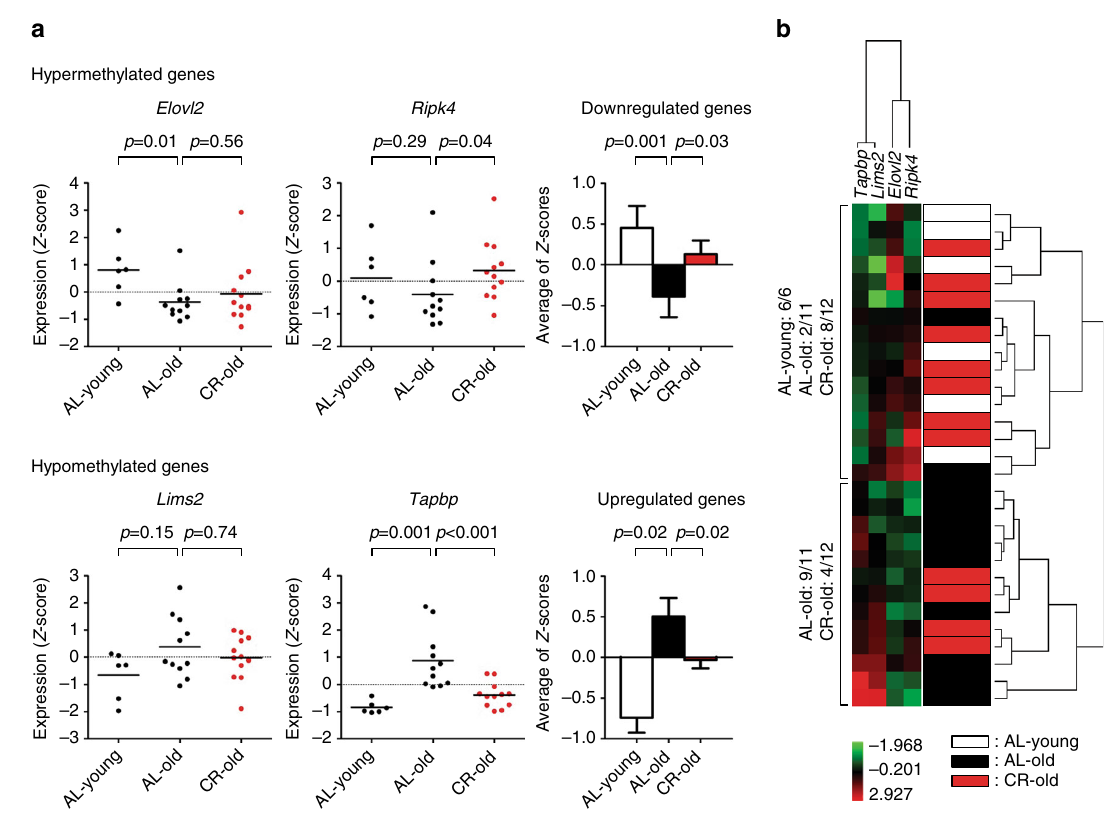
Fig. 6 Expression of genes showing age-related methylation in mouse liver. a Gene expression in liver measured by quantitative RT-PCR. Values were normalized to the expression of Gapdh . The expression data for each gene were Z -score transformed. Each dot corresponds to one individual (AL young, n = 6, AL old, n = 11, CR old, n = 12). The values are presented as means of triplicate analyses. Z -scores were averaged for age-related hypermethylated and hypomethylated genes ( bar graph , right side ). White , black , and red solid bars represent the expression level of genes in AL young, AL old, and CR old samples, respectively. Bars represent standard errors. p -values were obtained using the unpaired t -test with Welch ’ s correction. b Unsupervised hierarchical cluster analysis of gene expression data. Expression values were Z -score transformed. Green boxes indicate lower expression than the mean expression and red boxes depict higher expression. ( Red ; high expression, green ; low expression.) The dendrogram is shown at the right of the fi gure. The color codes of caloric status and age are shown on the